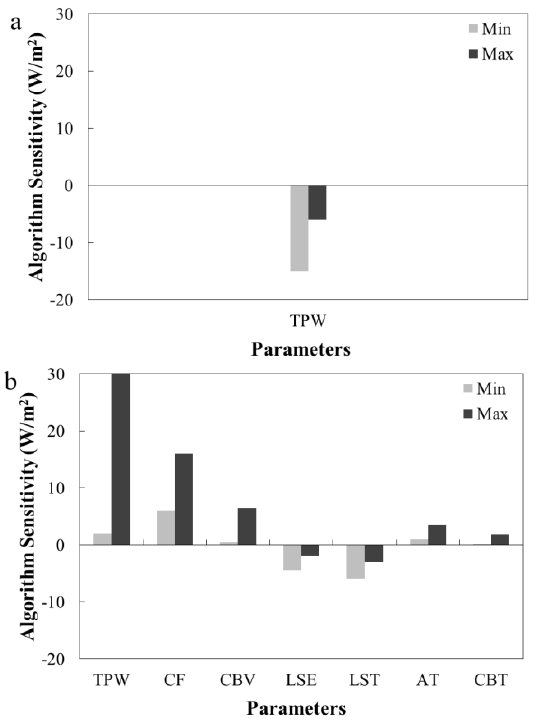
Figure 3. Algorithm sensitivity due to unit variation of input parameters, including the situation of (a) NSW and (b) NLW